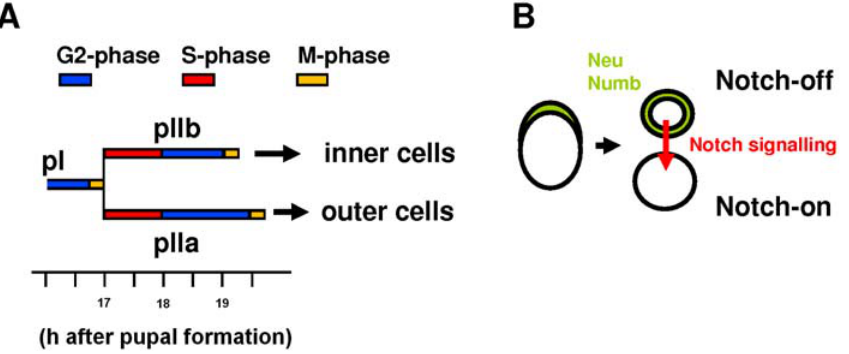
Figure 1. The bristle lineage. (A) pI cells divide giving rise to two secondary precursor cells, pIIb and pIIa. The former, after two rounds of divisions, produces the inner cells and the latter, after one round of division, the outer cells. The corresponding cell cycle phases are shown in colour (modified from [19]). (B) Asymmetric cell division of pI. The differential segregation of Numb and Neuralized (Neu) during pI division triggers unidirectional Notch-signalling to the posterior cell. As such, the anterior sister cell becomes the ligand sender (N-off, pIIb) and the posterior cell the signal receiver (N-on, pIIa).